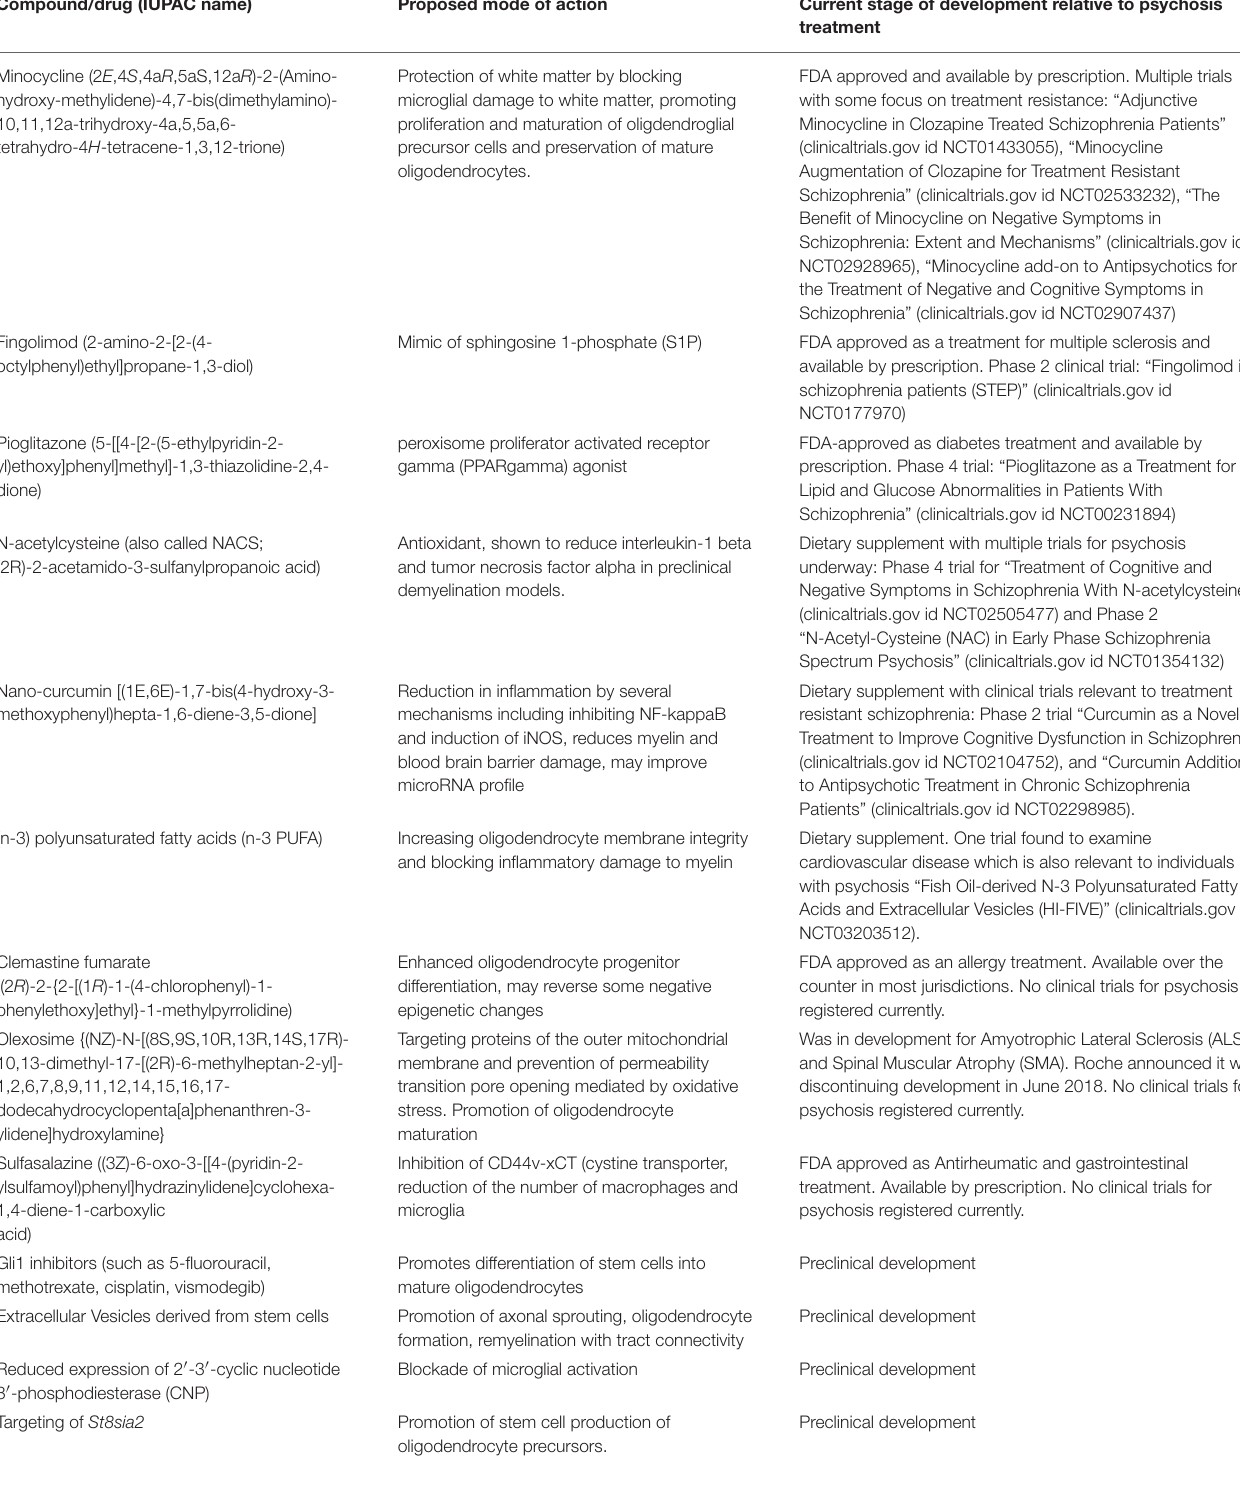
TABLE 2 | List of potential therapeutics targeting white matter for treatment resistant